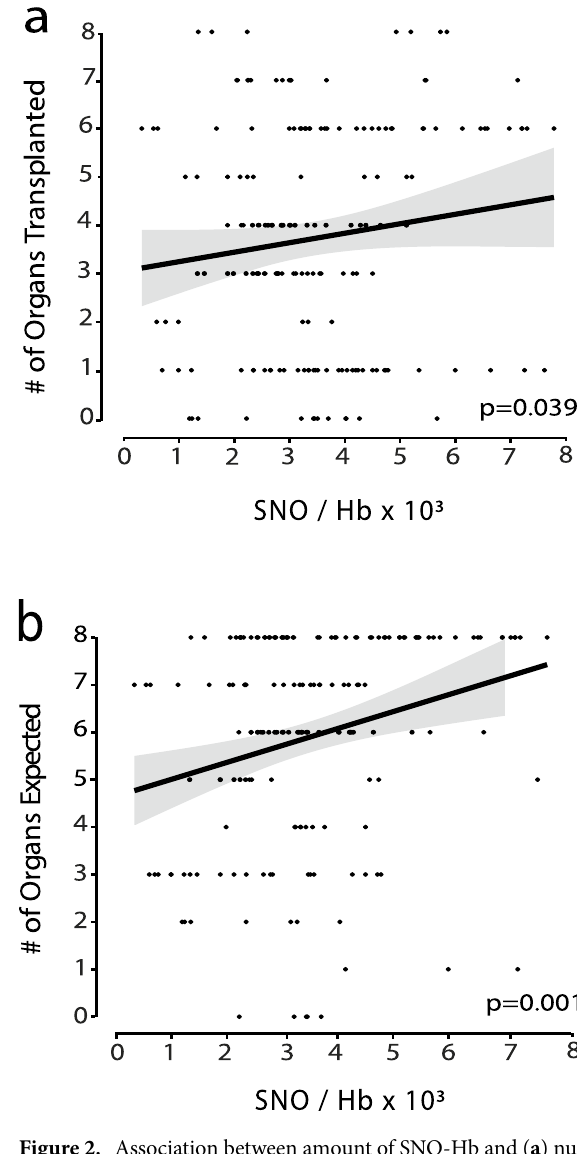
Figure 2. Association between amount of SNO-Hb and ( a ) number of organs transplanted, and ( b ) expected organs with Poisson regression